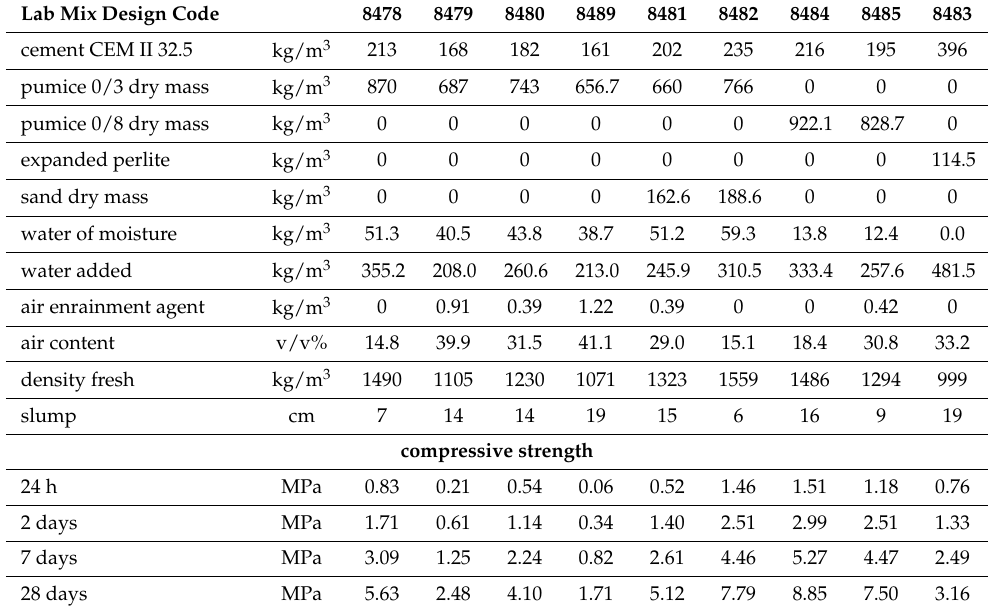
Table 2. Representative laboratory